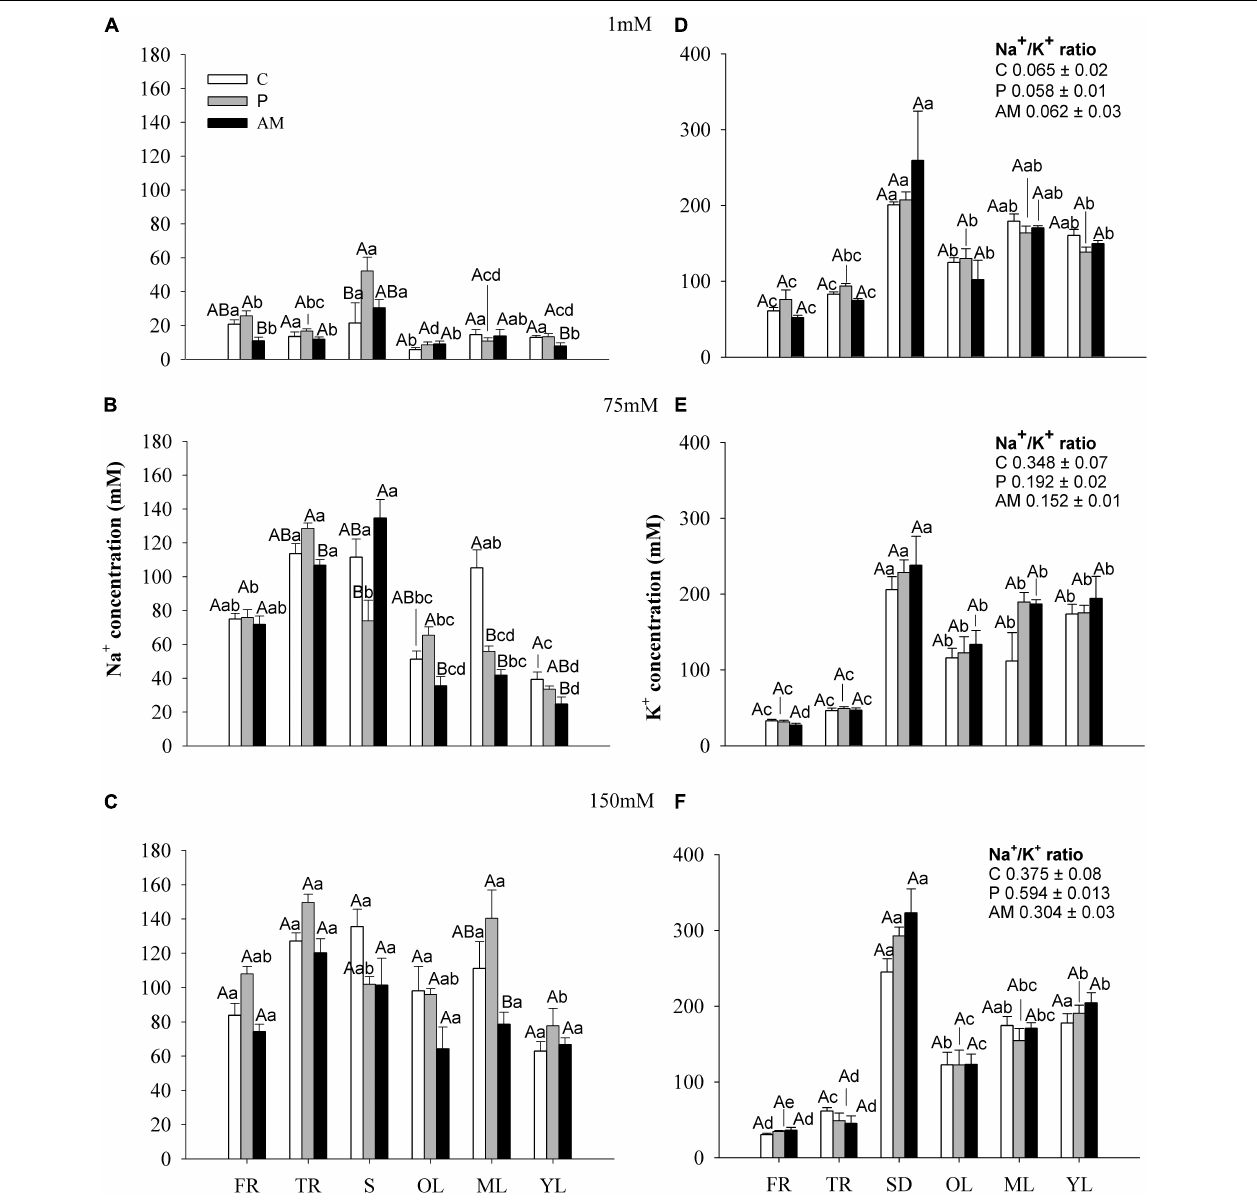
FIGURE 4 | Sodium and potassium concentration: (A–C) show Na + concentration (mM), and (D–F) show K+ concentration (mM) of different tissues (fine root – FR; thick root – TR; stem – S; old leaf – OL; mature leaf – ML and young leaf – YL) at 1, 75 and 150mM salt levels, of C, P and AM plants (white, gray and black bars, respectively). Values of ML Na + /L + ratio are show in a nested chart. Values are mean and SE of six replicates. Different capital letters indicate significant differences among nutritional levels (C, P and AM) within the same tissue, and lowercase letters indicate significant differences among tissues within the same nutritional level, from post hoc Tukey